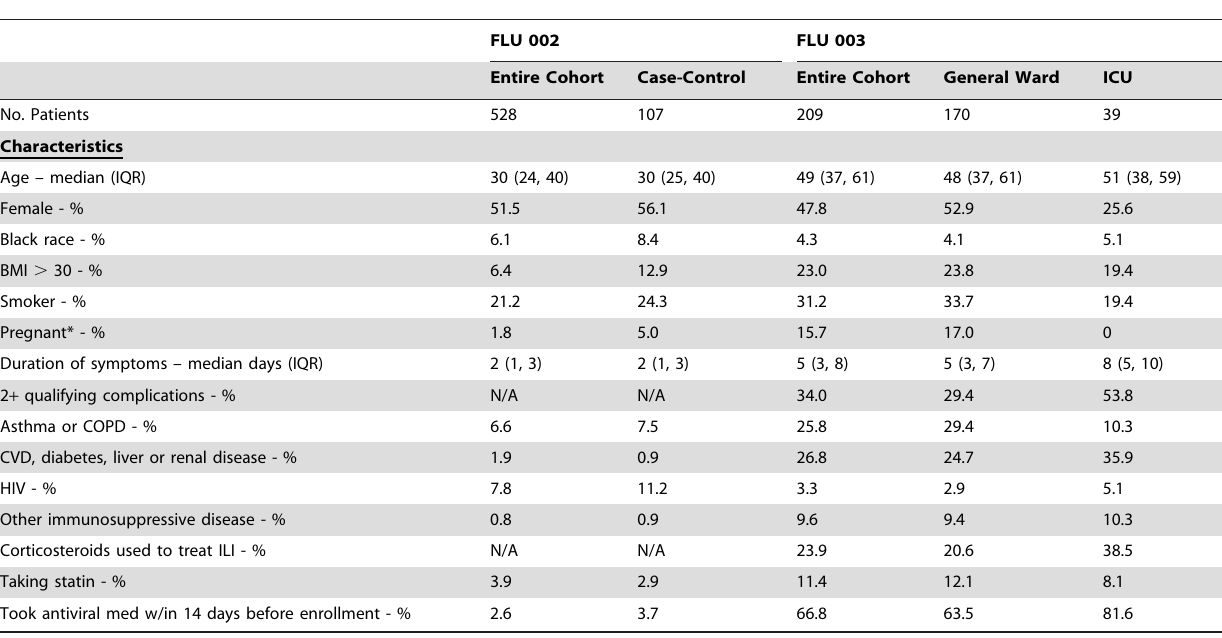
Figure 1. Biomarker study designs. The respective study designs and distribution of patients with and without severe disease outcomes in the outpatient case-control study FLU 002 (A) and in the hospitalization cohort study FLU 003 (B). doi:10.1371/journal.pone.0057121.g001 Table 1. Baseline Characteristics of the FLU 002 and FLU 003 Cohorts: Patients with Central Laboratory Confirmed A(H1N1)pdm09